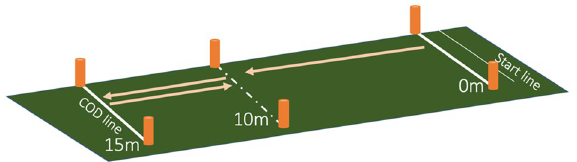
Figure 1. Setup of 5–0–5